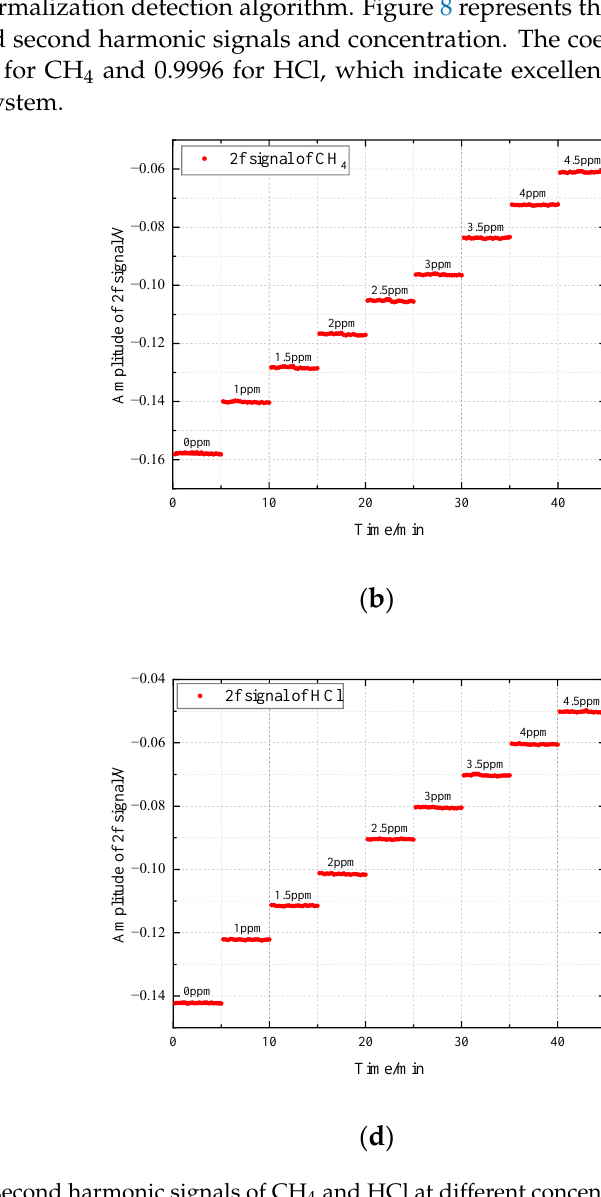
Figure 7. Measured first and second harmonic signals of CH 4 and HCl at different concentrations: ( a ) first harmonic signal of CH 4 .; ( b ) second harmonic signal of CH 4 .; ( c ) first harmonic signal of HCl.; ( d ) second harmonic signal of HCl.